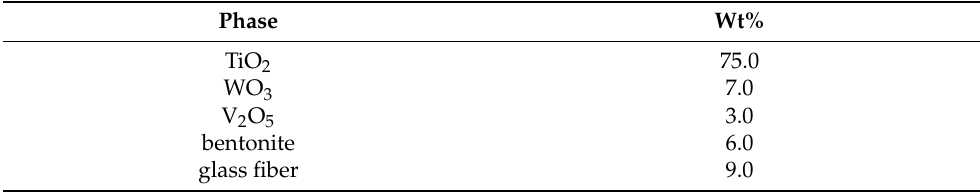
Table 2. Chemical composition of the monolithic